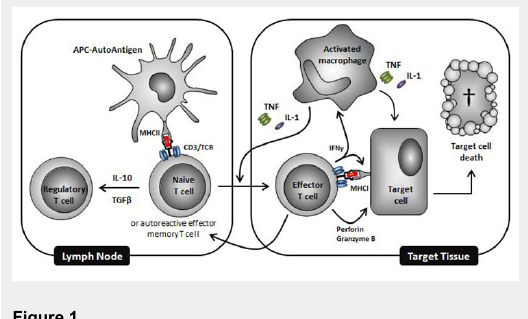
Schematic representation of some key immune mediators involved in the pathogenesis of autoimmune diseases. Combinations of drugs targeting distinct pathways in this process represent promising ways of curing autoimmune diseases.